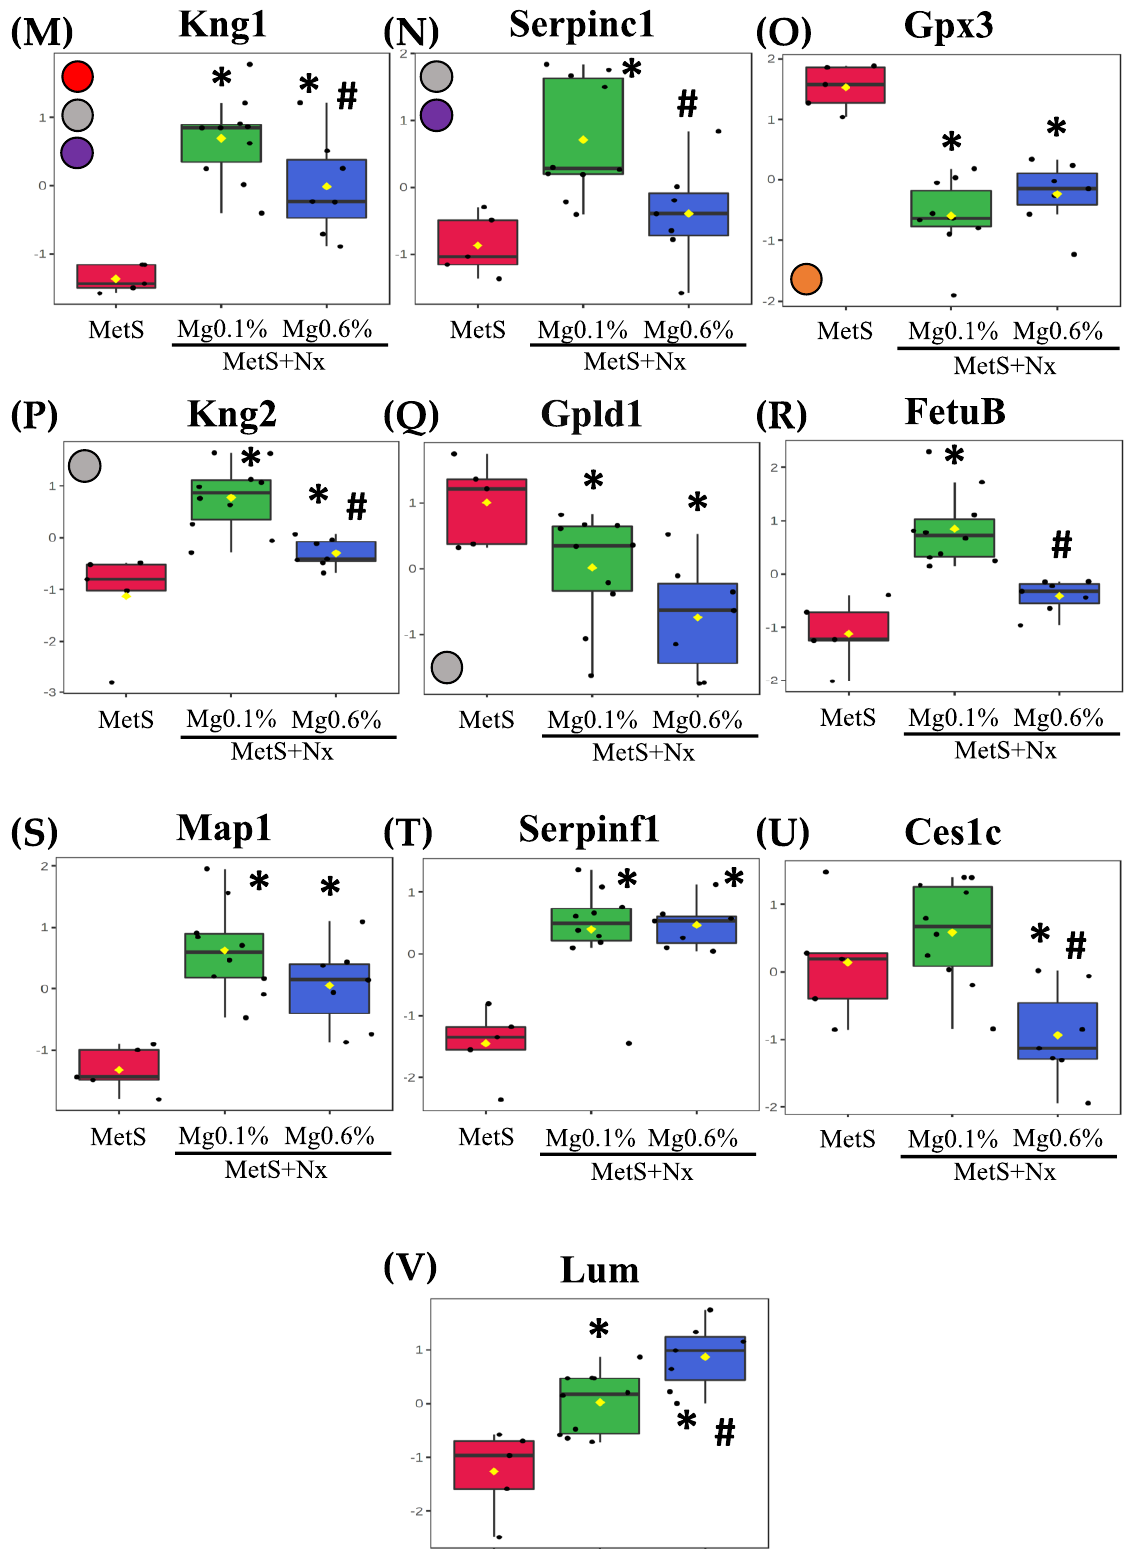
Figure 6. Plasma proteins differentially expressed in the proteomic study. After plasma proteomic study by DIA-SWATH the following proteins were statistically significant after comparison